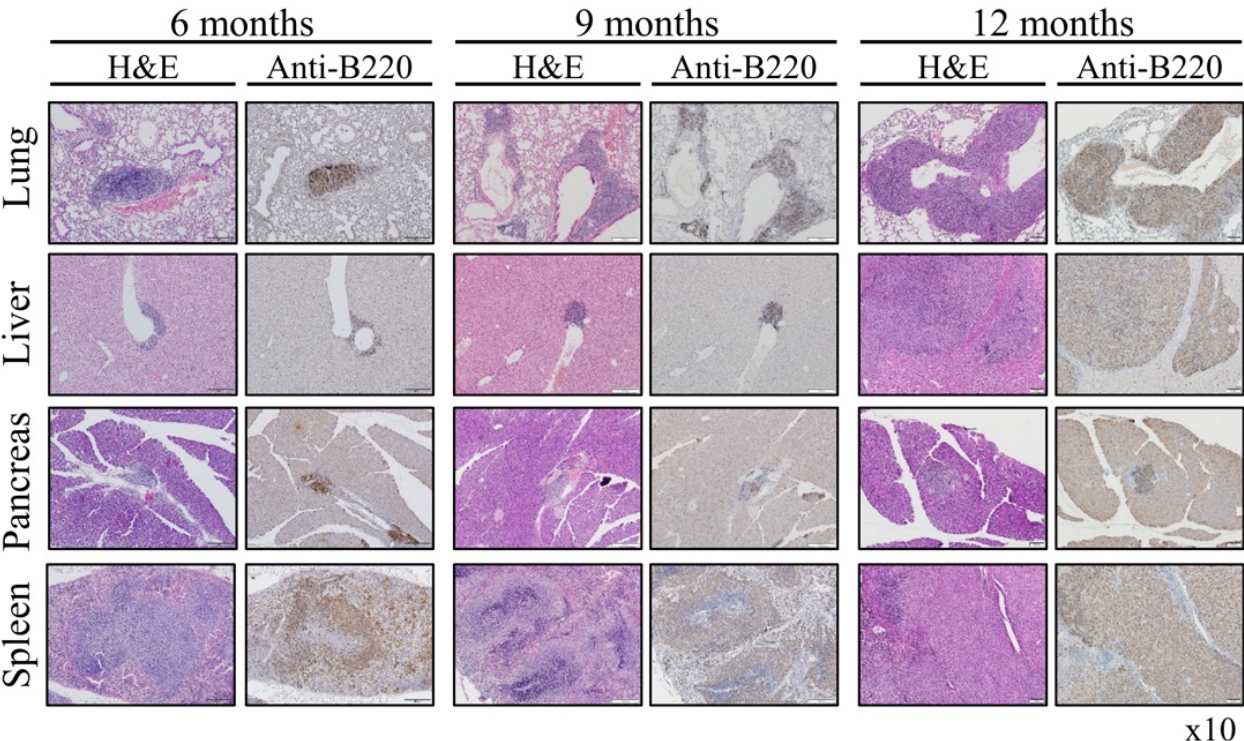
Figure 3. Presence of B cells in the Lymphomas of Rosa Vav1 mice. Sections of lung, liver, pancreas, and spleen from Rosa Vav1 mice either treated (+Dox) or non ‐ treated ( − Dox) at indicated time points after transgene induction, were stained with H&E and anti ‐ B220 antibodies. Representative pictures are shown. Magnification at ×10.